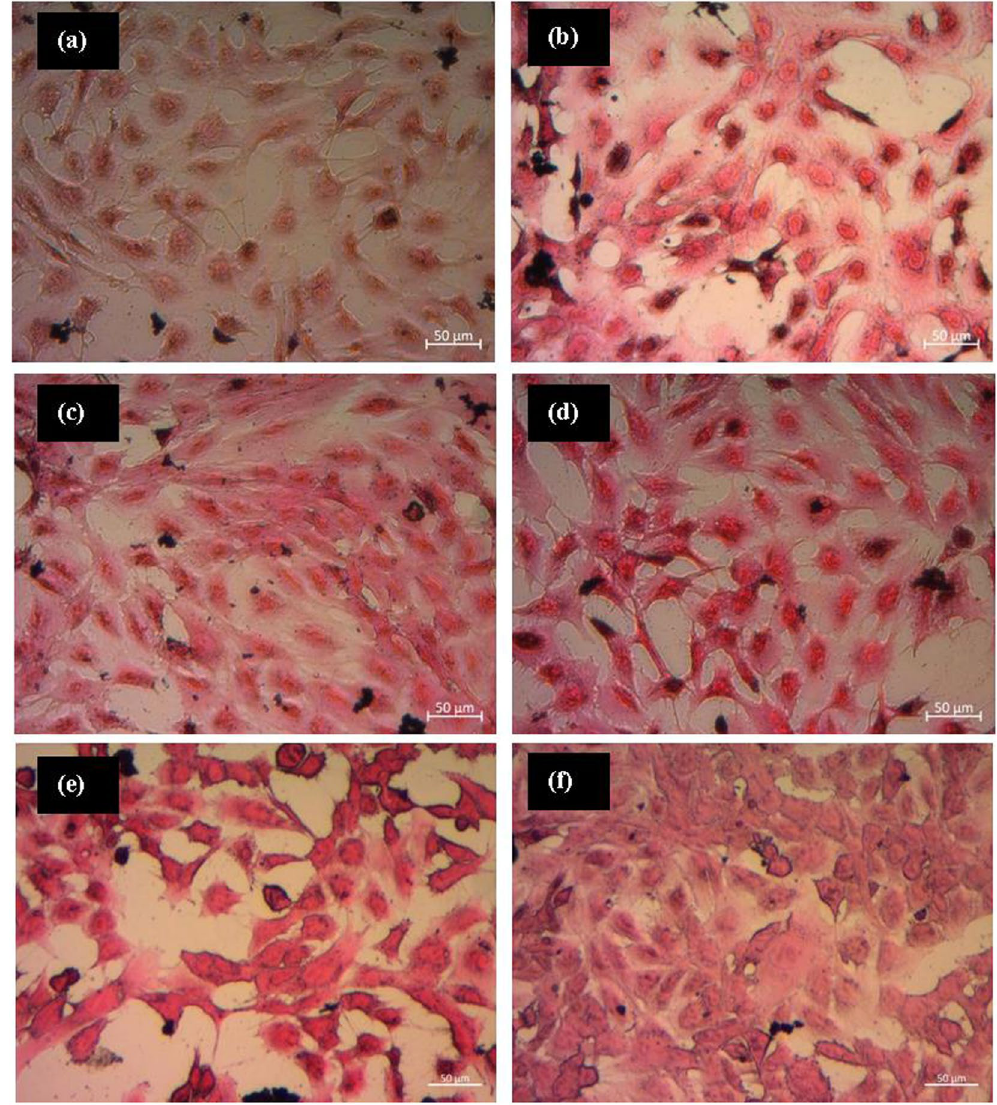
( a ) control, ( b ) pure PHBV, ( c ) PHBV/SPIONs Lauric 6:1, ( d ) PHBV/SPIONs Lauric 2.5:1, ( e ) PHBV/SPIONs Oleic 6:1,and ( f ) PHBV/SPIONs Oleic